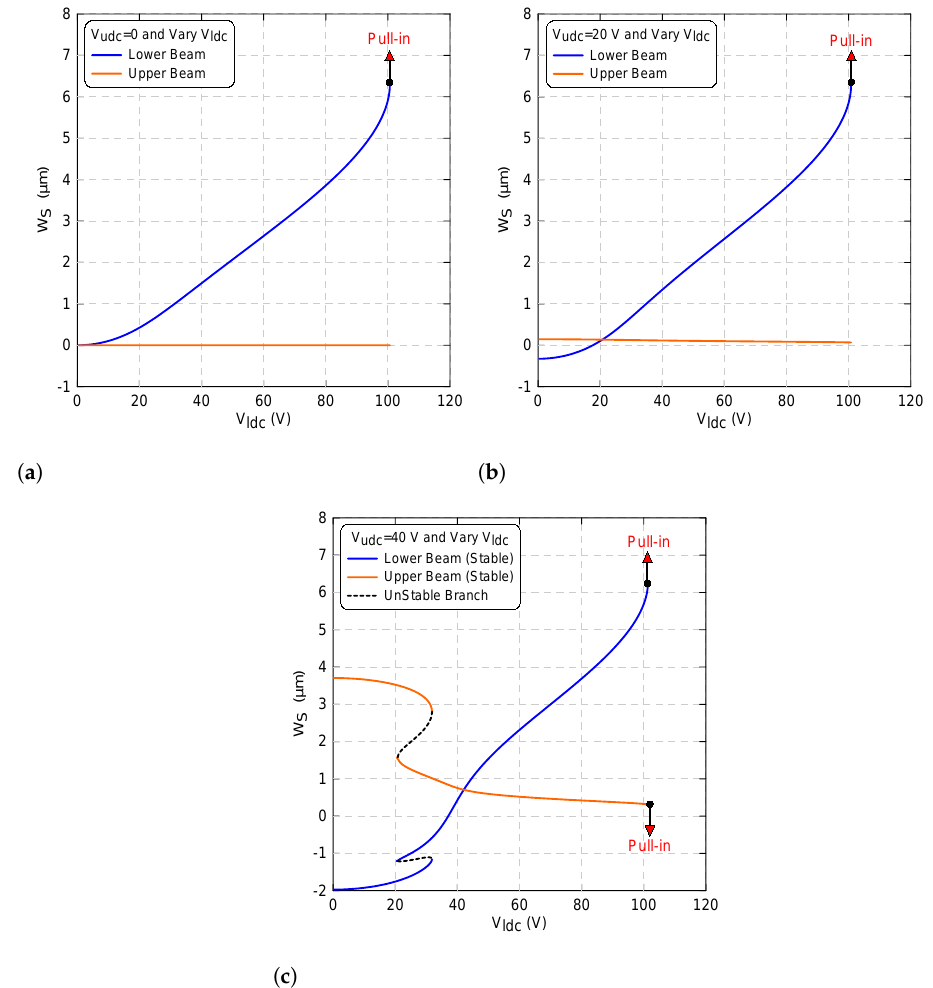
Figure 5. The beam mid-point deflections of the lower beam w ls ( 0.5 ) and of the upper beam w us ( 0.5 ) as a function of the lower static voltage using three-symmetric modes ROM and an upper voltage sets to: ( a ) V udc = 0, ( b ) V udc = 20 V and ( c ) V udc = 40 V. The stable static equilibria of the lower beam are marked with blue lines, the stable static equilibria of the upper beam are marked with orange lines whereas the unstable static equilibria are marked with dashed black